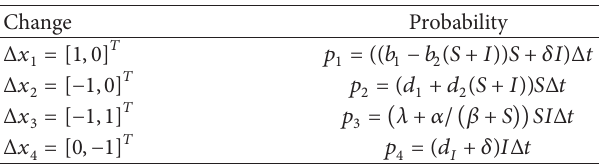
Table 2: Possible changes in the two-population system (4) with the probabilities.